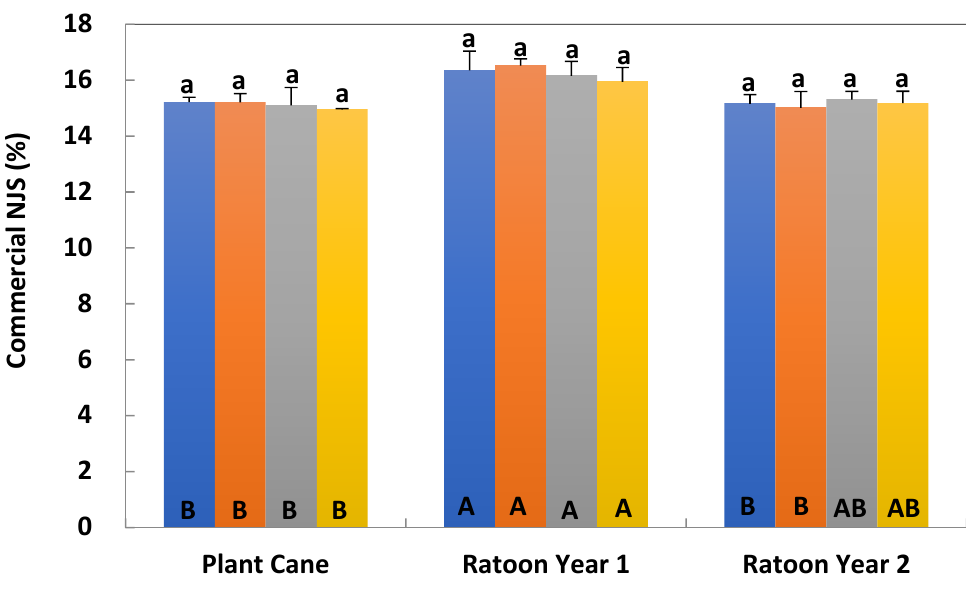
Figure 5. Commercial NJS% for plant cane and two ratoons (mean and standard deviation). Different lower case letters within the same crop year are significantly different ( p < 0.05). The same treatment with different upper case letters for plant cane and two ratoons are significantly different ( p < 0.05).